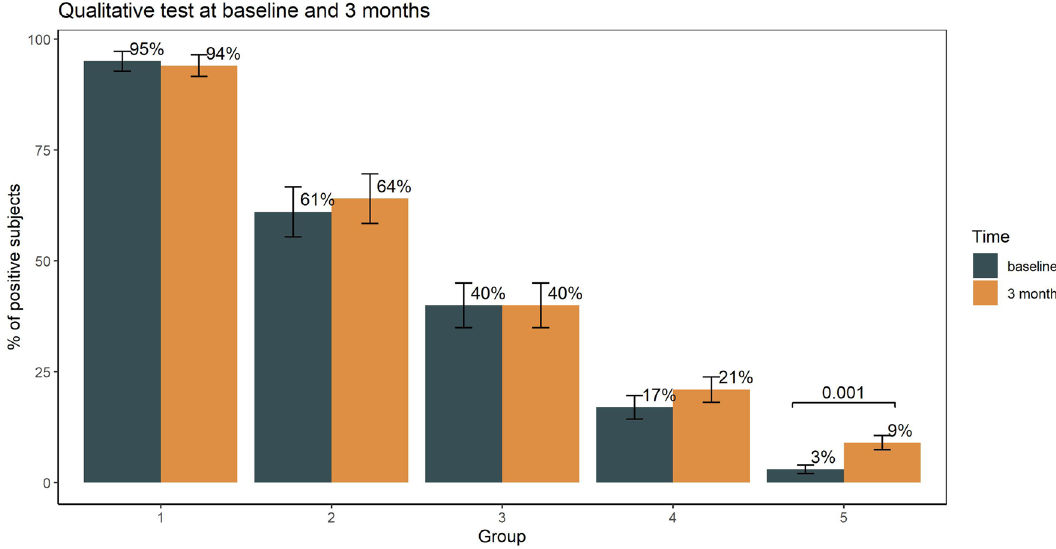
Figure 1. Percentage of subjects who tested positive to qualitative in vitro detection of antibodies at baseline and 3 months follow-up. Statistical differences were examined by McNemar